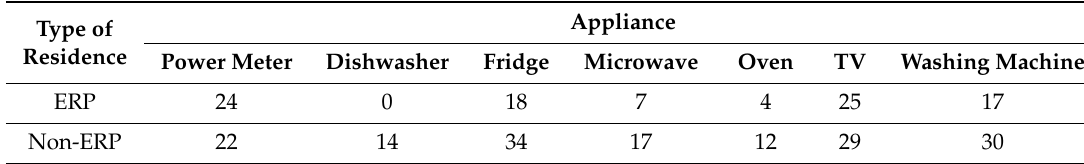
Table 3. The number of monitored